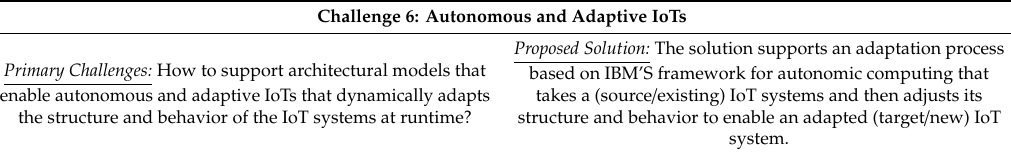
Table 10. Challenge VI— Overview of the challenges and architectural solutions for autonomous and adaptive